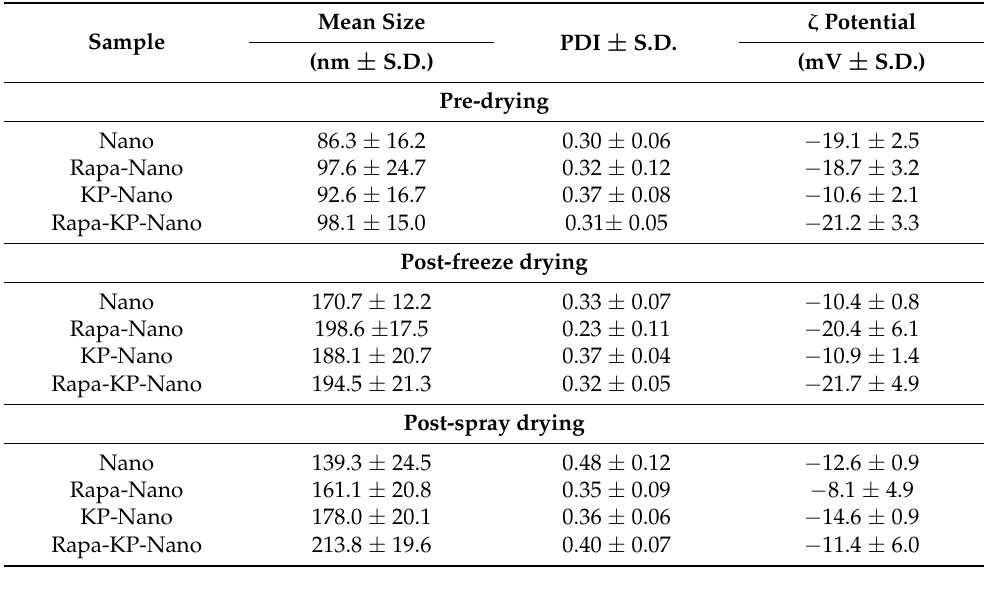
Table 4. Mean size, PDI and ζ potential values of empty and Rapa-loaded Nano and KP-Nano in bidistilled water, after freeze-drying or spray-drying (SD) in the presence of man. Data represent the media of three measurements.